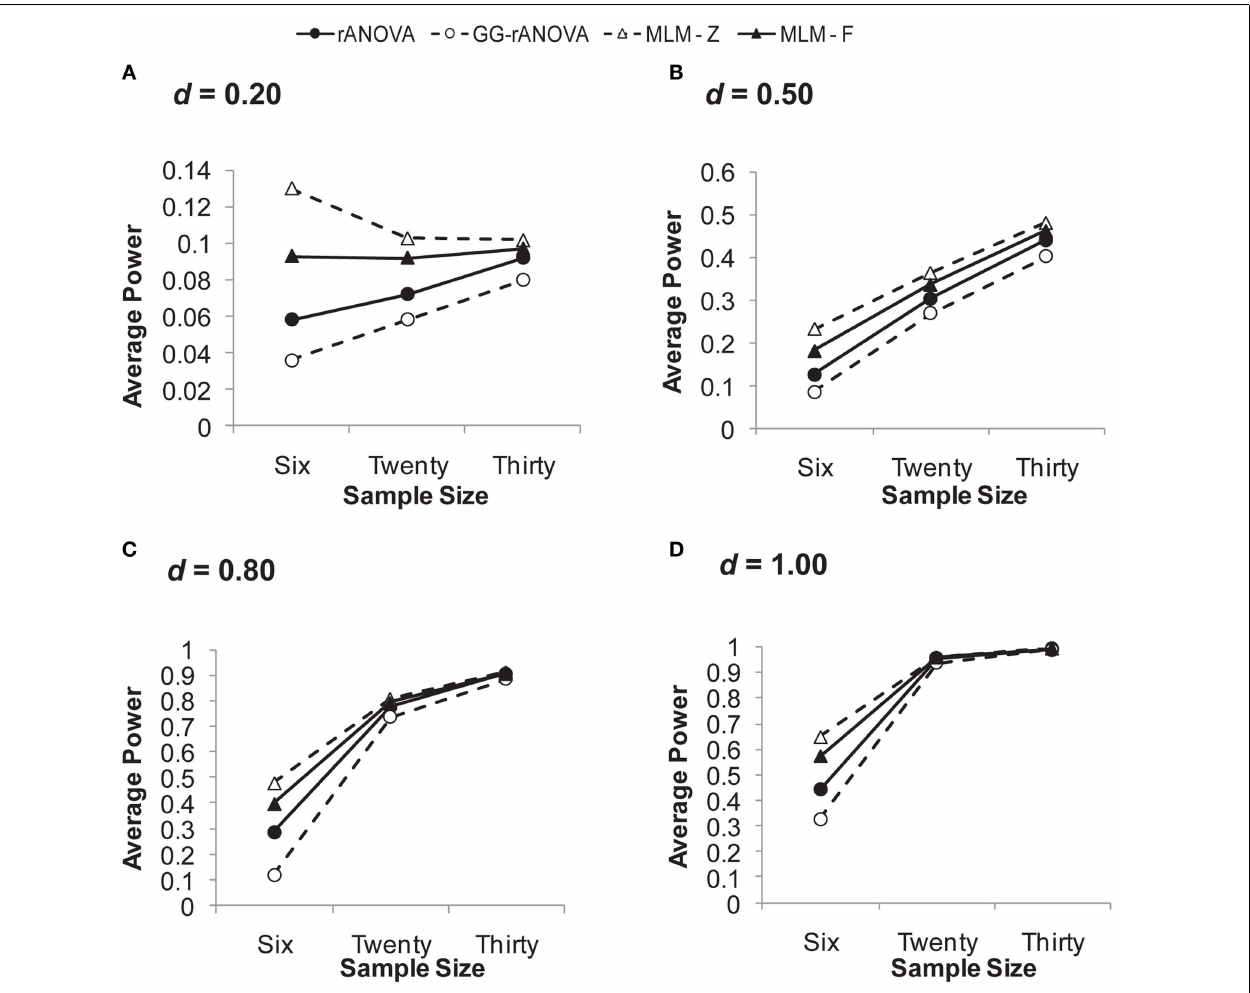
rANOVA = repeated measures ANOVA, GG-rANOVA is Greenhouse–Geisser corrected repeated measures ANOVA, MLM- Z isWald’s Z from the MLM, MLM- F is the between-within df for F from the